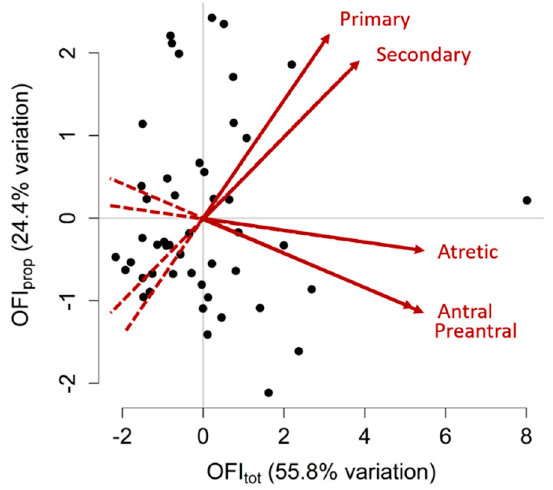
Figure 2. Principal component analysis for ovarian follicle counts. Two variables, or Ovarian Follicle Indices (OFIs), were created to summarise the primary, secondary, preantral, antral and atretic follicle counts of each gilt. This graph shows two OFIs that were created, OFI tot and OFI prop , which cumulatively explained 80.2% of the variation in follicle populations observed between gilts. Each point on this graph represents an individual gilt, plotted according to her two OFI values. Gilts with higher OFI tot values have greater follicle numbers of all types, whereas gilts with higher OFI prop values had greater primary and secondary follicle counts and lesser preantral, antral and atretic follicle counts. Points distributed towards the arrowheads of the red vectors have greater counts of the corresponding ovarian follicle type (labelled in red) than points located towards the tail-end of the vectors. Positively correlated traits have vectors that point in the same direction, negatively correlated traits have vectors that point in opposite directions and traits that have no correlation have vectors that are perpendicular to each other.